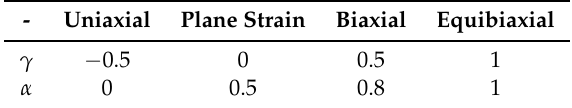
Table 1. Incremental strain and stress ratios for four different load